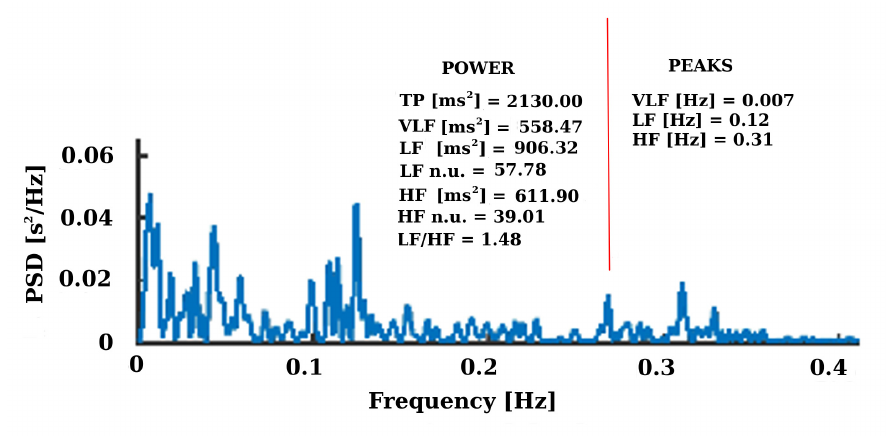
Figure 3: Spectral analysis on healthy subjects showing indexes’ values in the frequency domain. The abscissa and ordered axis present the PSD and the frequency,